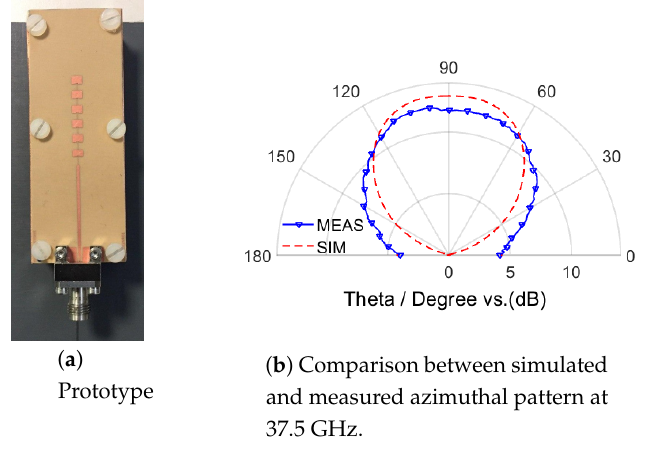
Figure 3. Single element antenna.